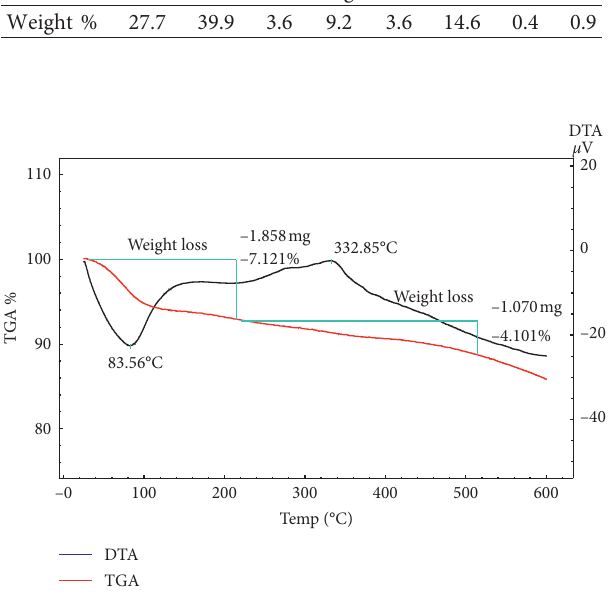
Figure 5: DTA/TGA thermogram of the Rh-P.